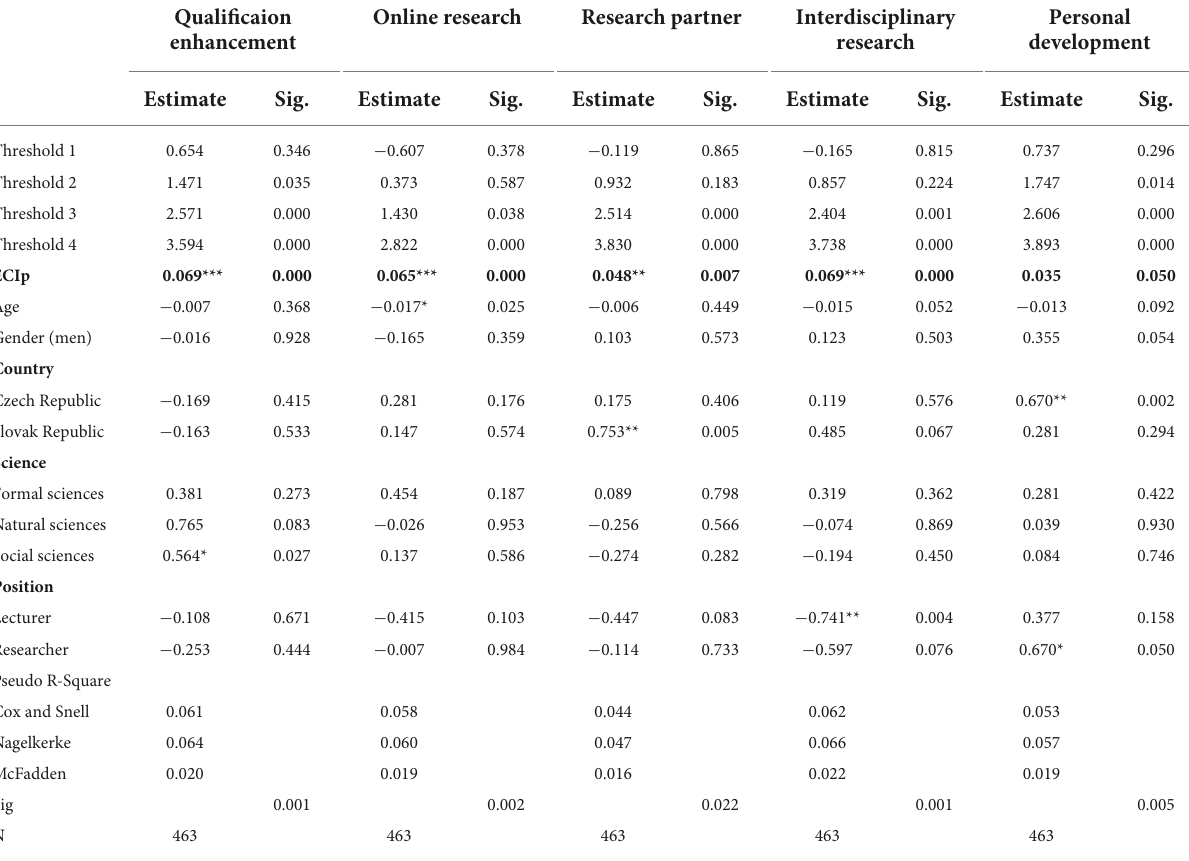
TABLE 6 The preparedness component of emotional creativity (ECIp) predicts motivation for innovative research as a response to online teaching during the COVID-19 epidemic. Qualificaion